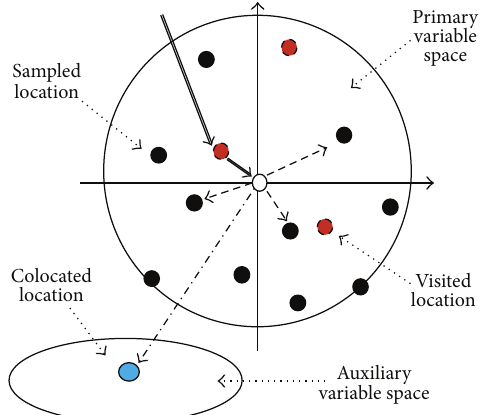
Figure 2: Illustration of the Markov chain random field colocated cosimulation model with quadrant search and one auxiliary variable for random-path sequential simulation. Double arrows represent the moving directions of the spatial Markov chain. Dashed arrows represent the interactions of the spatial Markov chain with nearest neighbors and auxiliary